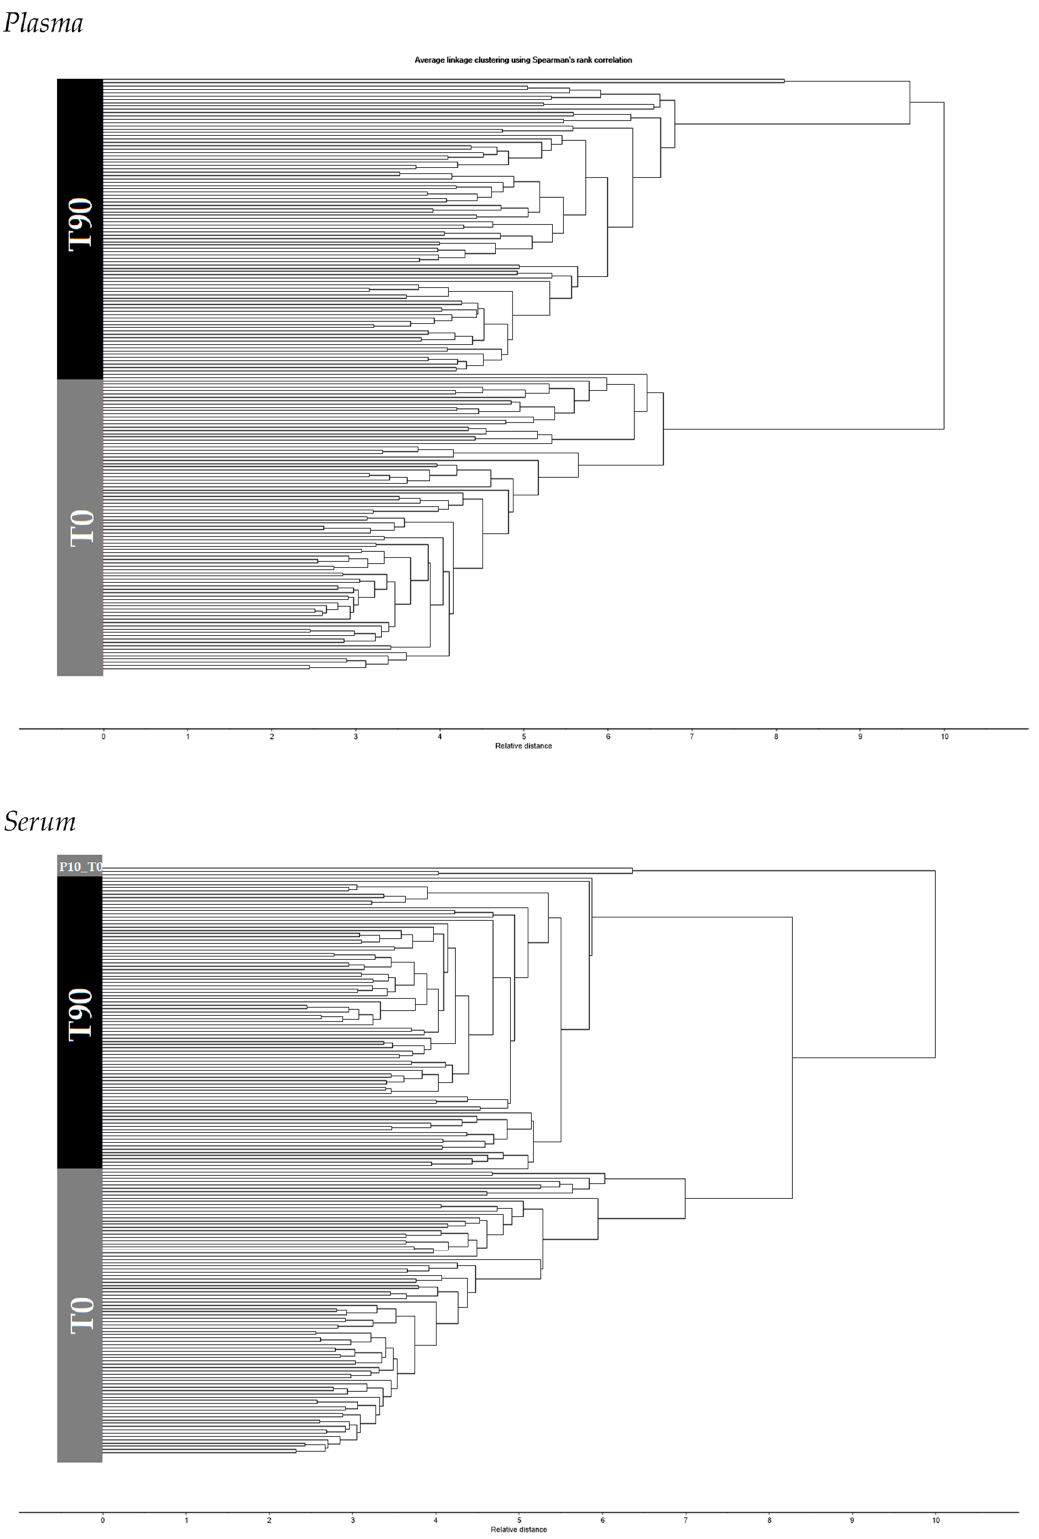
Figure 3. HCA of plasma and serum spectra pre-processed by atmospheric correction, second derivative, and unit vector normalization, relative to T0 and T90, respectively.